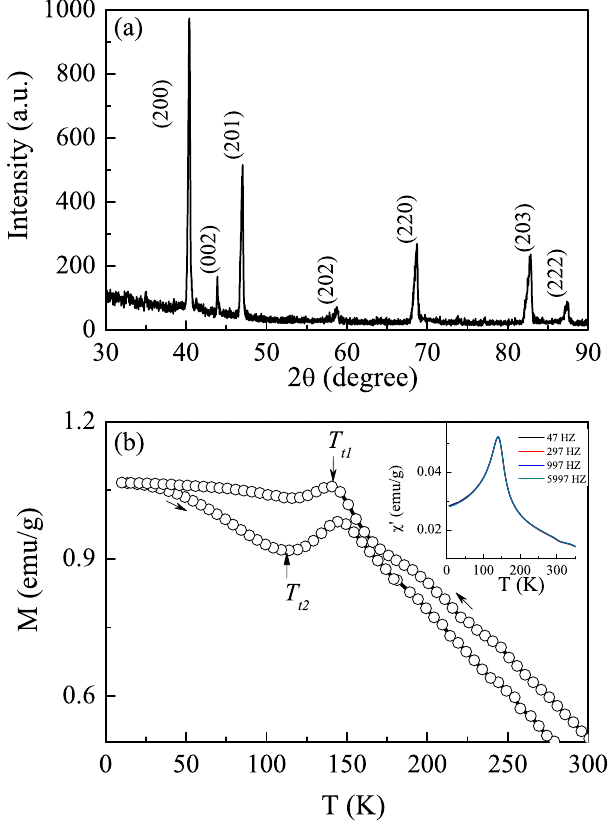
Figure 2. ( a ) XRD patterns measured at room temperature for Mn 3 Ga plate sample. ( b ) FC and FH curves measured at 100 Oe field for Mn 3 Ga. Inset of Fig. 2(b) is temperature dependence of the real part ( χ ′ ) of AC susceptibility measured at different frequencies with an ac magnetic field of 5 Oe after zero field cooling to 5